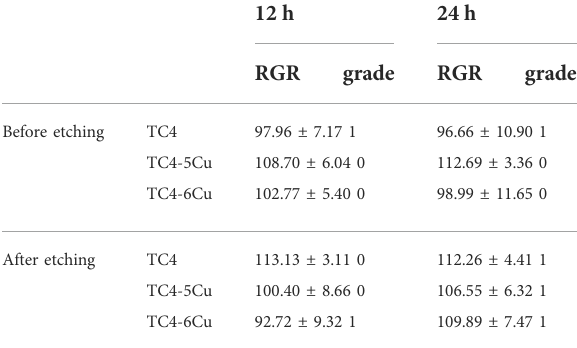
TABLE 2 Relative growth rate (RGR) and cytotoxicity level at different detection